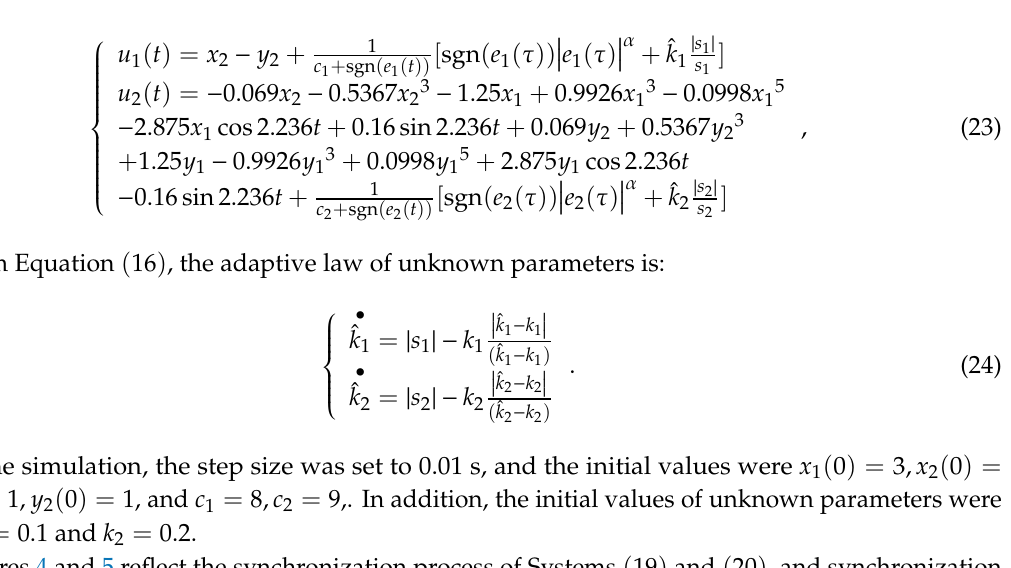
Figure 5. Synchronization process of 2 Figure 6. Synchronization errors. Figure 7. Identification process of